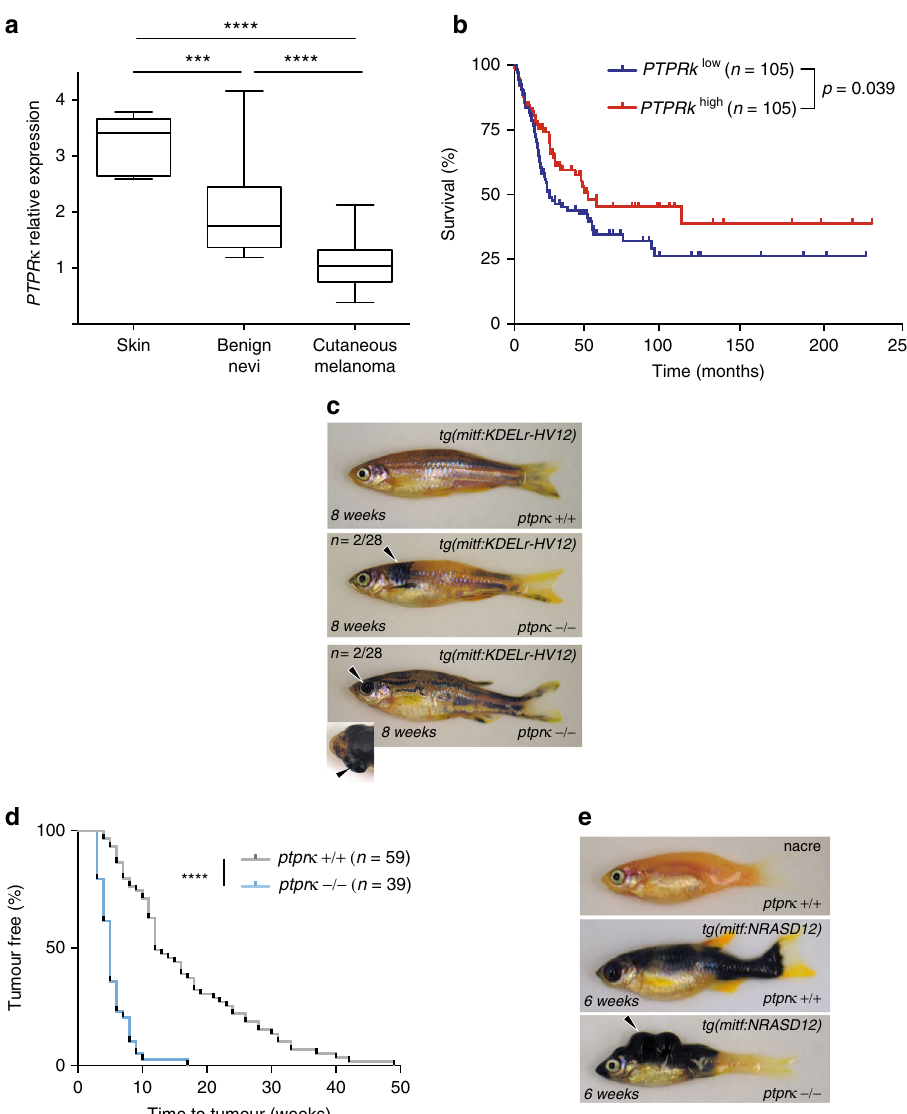
Fig. 9 PTPR κ is a tumor suppressor in melanoma. a Analysis of PTPR κ expression in normal skin ( n = 7), benign nevi ( n = 18) and cutaneous melanoma samples ( n = 45) generated using an available gene dataset, accessed through the Oncomine ® platform. *** p < 0.001 **** p < 0.0001 by Student's t -test. b Survival curves for melanoma patients depending on PTPR κ expression levels (obtained from GEO GSE65904). c View of naevi (2/28; arrowhead, middle panel) and melanoma (2/28; arrowhead bottom panel, points to a protruding eye with a retroorbital tumor.) by 52 weeks post fertilization in ptpr κ nullizygous zebra fi sh expressing KDELr-HV12 as a transgene. Representative pictures were taken at 8 weeks post fertilization. d Kaplan – Meier plot of tumor development in ptpr κ wild-type nacre animals compared to ptprk − / − nacre animals, injected with NRAS-G12D. **** p < 0.0001 by Mantel-Cox test. e Representative melanoma lesions (see arrowheads) in zebra fi sh with the indicated ptpr κ genotype expressing NRAS-G12D as a transgene. See